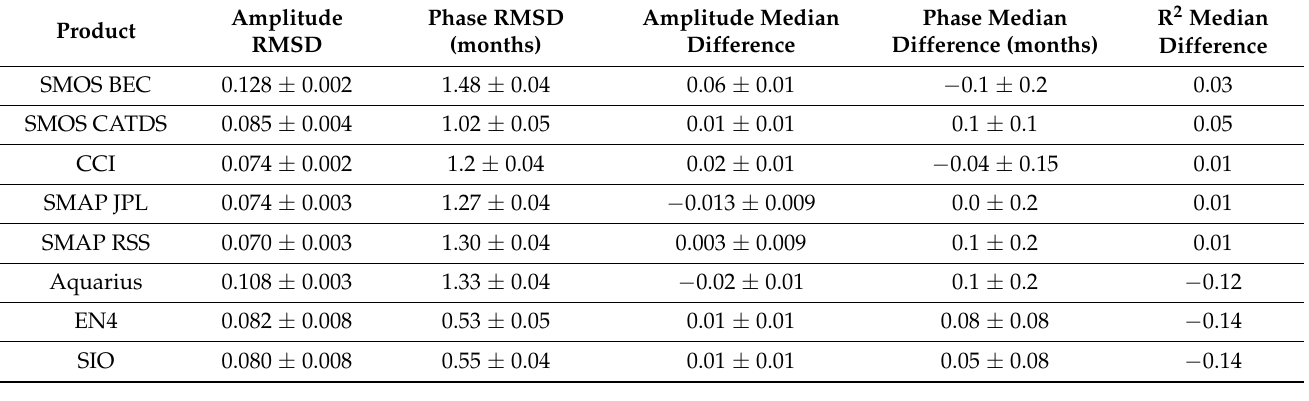
Table 2. Columns 2–5: amplitude and phase discrepancies between mooring and satellite or gridded in situ products. Median differences are mooring—product. Column 6: median difference in R 2 between mooring and satellite or in situ product for the annual harmonic. Positive number means mooring R 2 is greater.